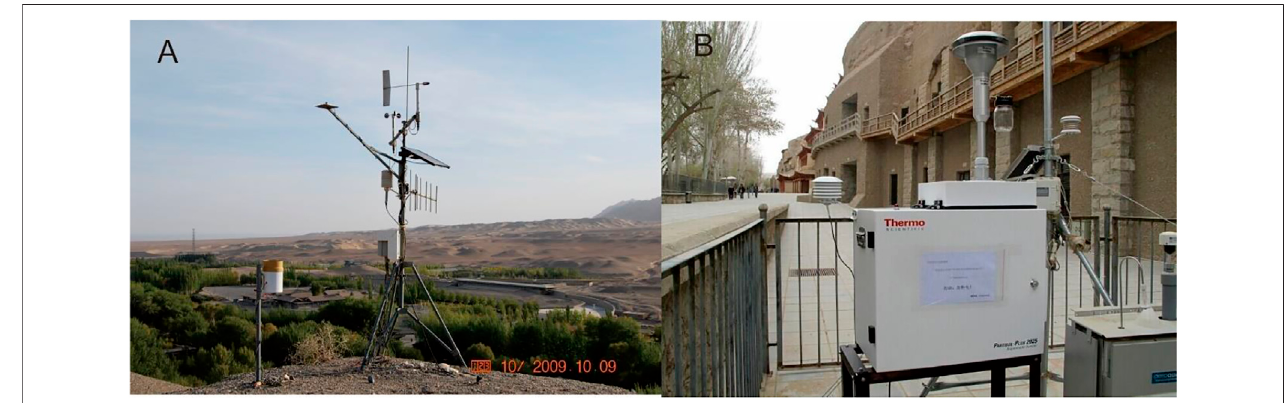
FIGURE 3 | The Metstn weather station on the top of the Mogao Grottoes (A) and Thermo Scienti fi c ™ Partisol ™ 2025i Sequential Air Sampler in front of the Grotto 72 (B) .